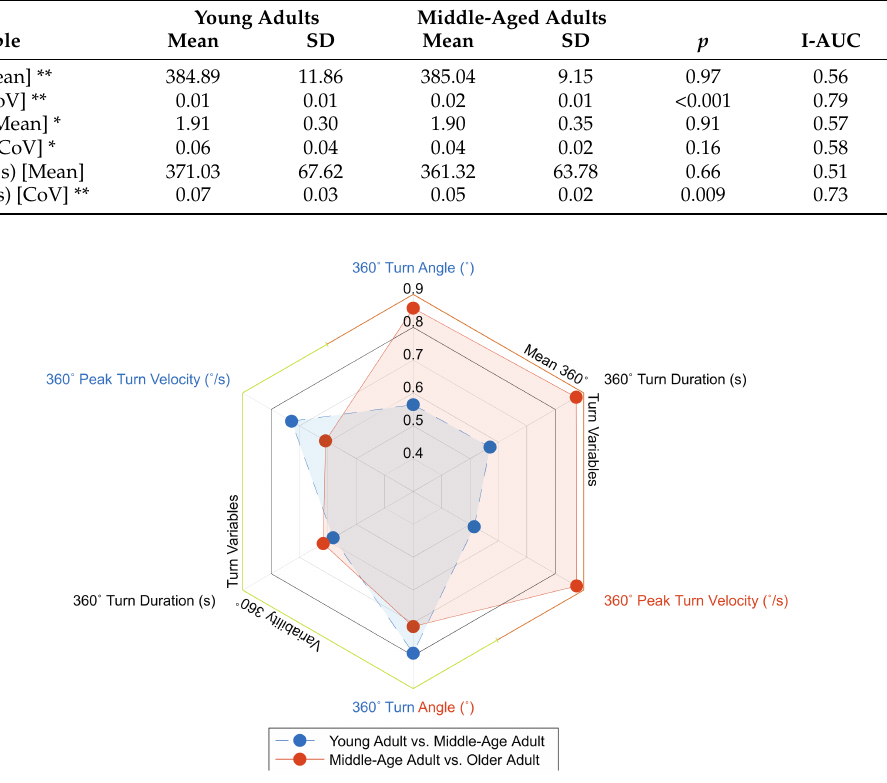
Figure 3. Spider plot denoting each 360 ◦ turning variable and their associated AUC values between groups. Colored variables represent those maintained in the stepwise regression model for each group